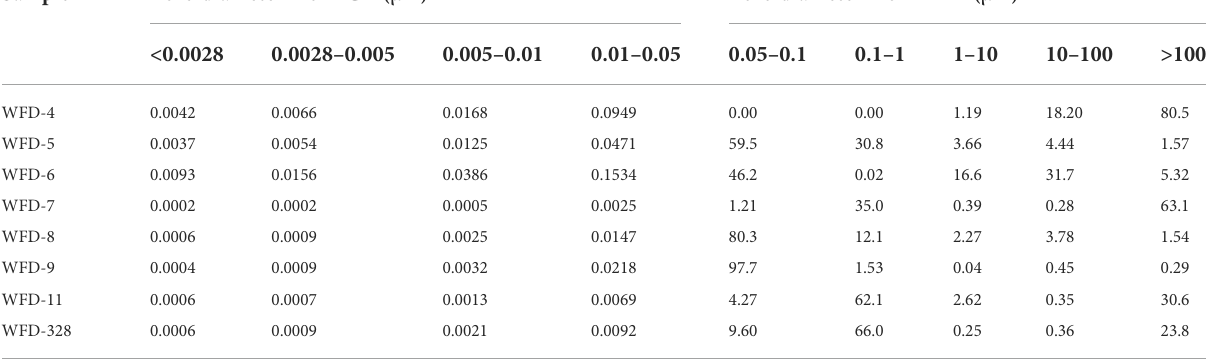
TABLE 6 Pore volume percentages from the combined GP-MIP data. Sample ID